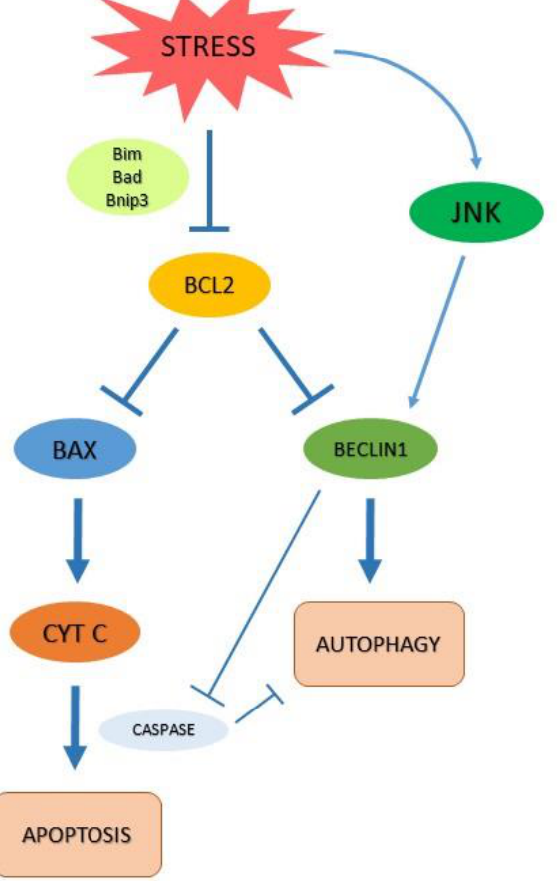
Figure 2. Autophagy and apoptosis interplay. Stress conditions can inhibit Bcl2 family through the phosphorylation of Bim/Bad/Bnip3. This condition results in liberation of Beclin1 and induction of autophagy, enhanced by the activation of c-Jun N-terminal kinases (JNKs). Subsequently, the oligomerization of the pro-apoptotic proteins BCL-2 antagonist killer 1 (BAK) and BCL-2-associated X protein (BAX) results in mitochondrial outer membrane permeabilization (MOMP), which leads to the release of cytochrome C (Cyt C). Cyt C will form a complex with pro-caspases, resulting in Caspases activation and Cell death. Apoptosis and autophagy may also inhibit each other through protein cleavage.